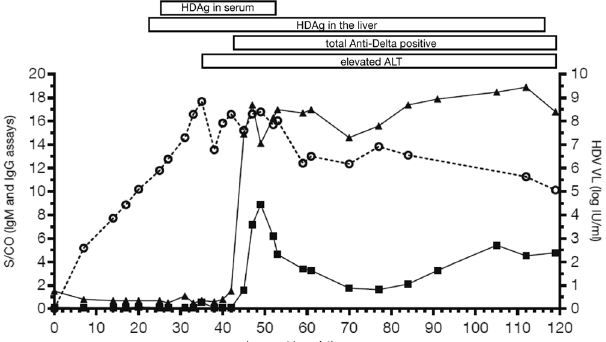
Figure 6. HDV superinfection progression to chronic HDV infection. Serial bleeds were tested for IgM and IgG specific responses using modified indirect assays. Plotted are S/CO values where cut-off was determined by taking 10 times the negative control for each assay (left Y-axis). S/CO ≥ 1.0 is considered reactive for both IgM and IgG assays. HDV viral load (log IU/ml) was determined using the Abbott HDV molecular assay (right Y- axis). Circle, viral load; square, IgM S/CO, triangle, IgG S/CO. Historic data is presented for HDAg in serum, HDAg in liver, elevated liver ALT, and total Anti-Delta (Abbott Anti-Delta EIA assay (3018) 25 . Presence of any of these markers is indicated by a solid